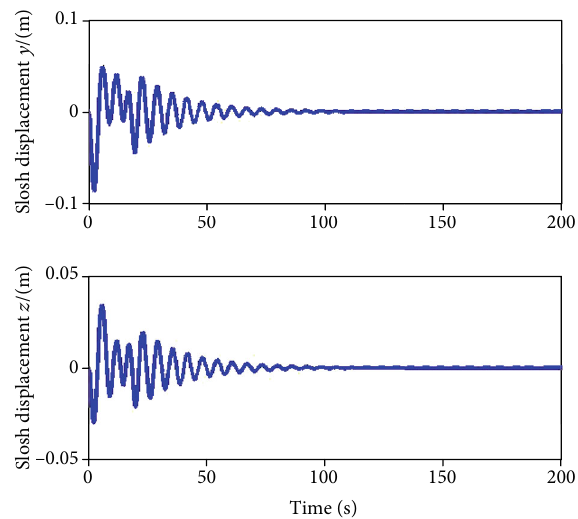
Figure 11: Time histories of liquid sloshing displacement in Case 2.